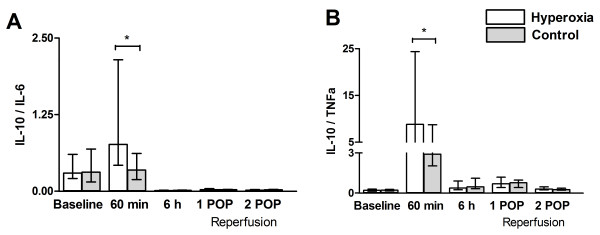
Ratio of IL-10/IL-6 (panel A) and IL-10/TNFα (panel B) at baseline, 6 h after declamping the aorta and in the 1stand 2ndpostoperative mornings (POP). Data are given as median with interquartile range. * p < 0.05 in comparison with baseline.